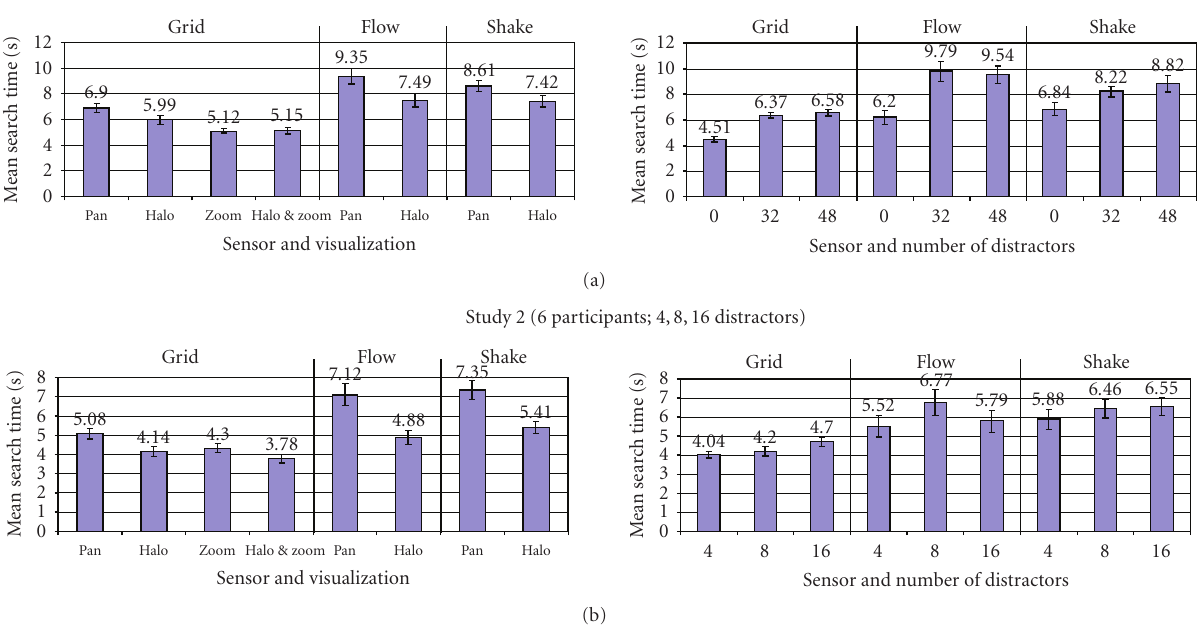
Figure 6: Mean search times for each sensing method grouped by navigation technique (left) and number of distractors (right). Note that the scaling of the y -axis is di ff erent for the upper and the lower panels.